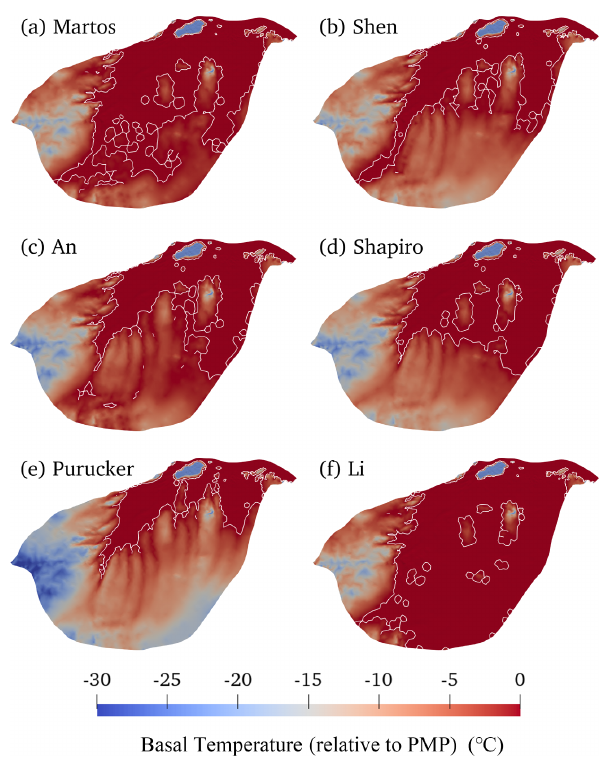
Figure 7. Modelled basal temperature relative to pressure melting point, in panels (a) to (f) , corresponding to the GHF in panels (a) to (f) in Fig. 2. The ice bottom at the pressure melting point is delin- eated by a white contour.